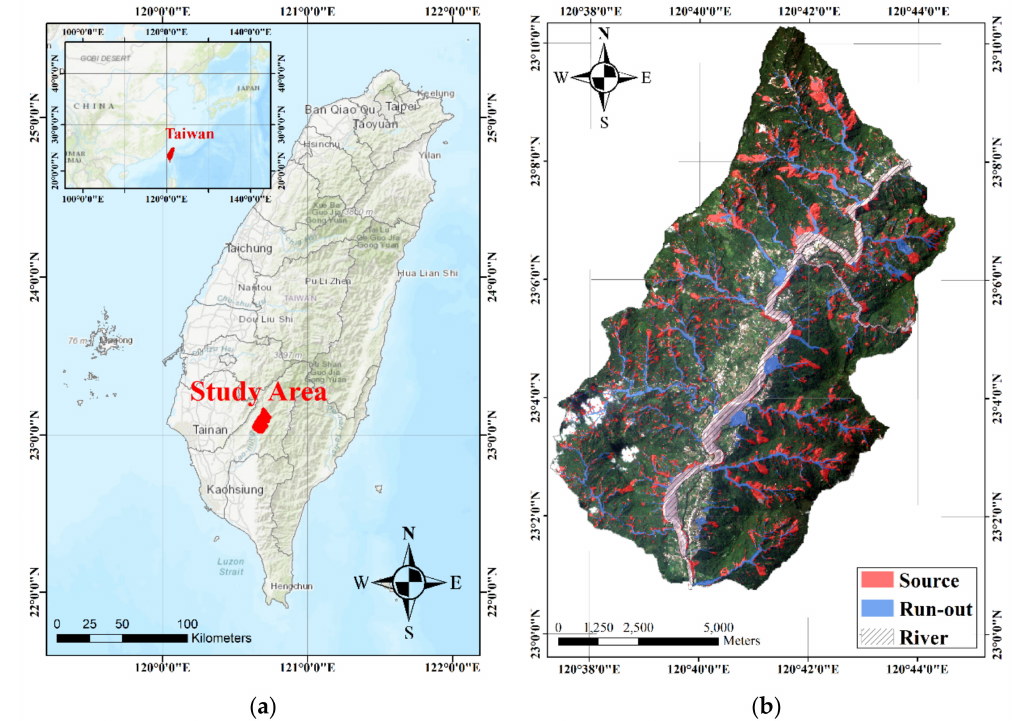
Figure 1. Location of the study site ( a ) and landslide inventory map ( b